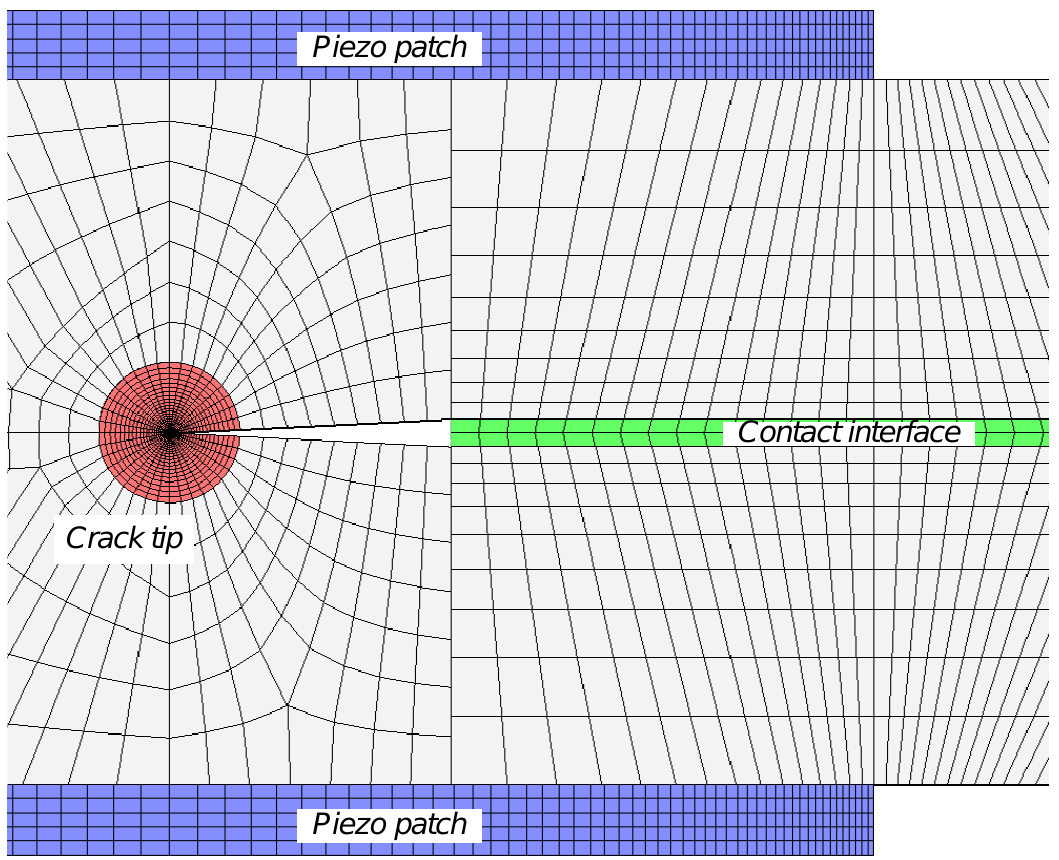
Figure 12. FE discretization for crack tip, piezoelectric patches and contact interface (adopted from Figure 3 in